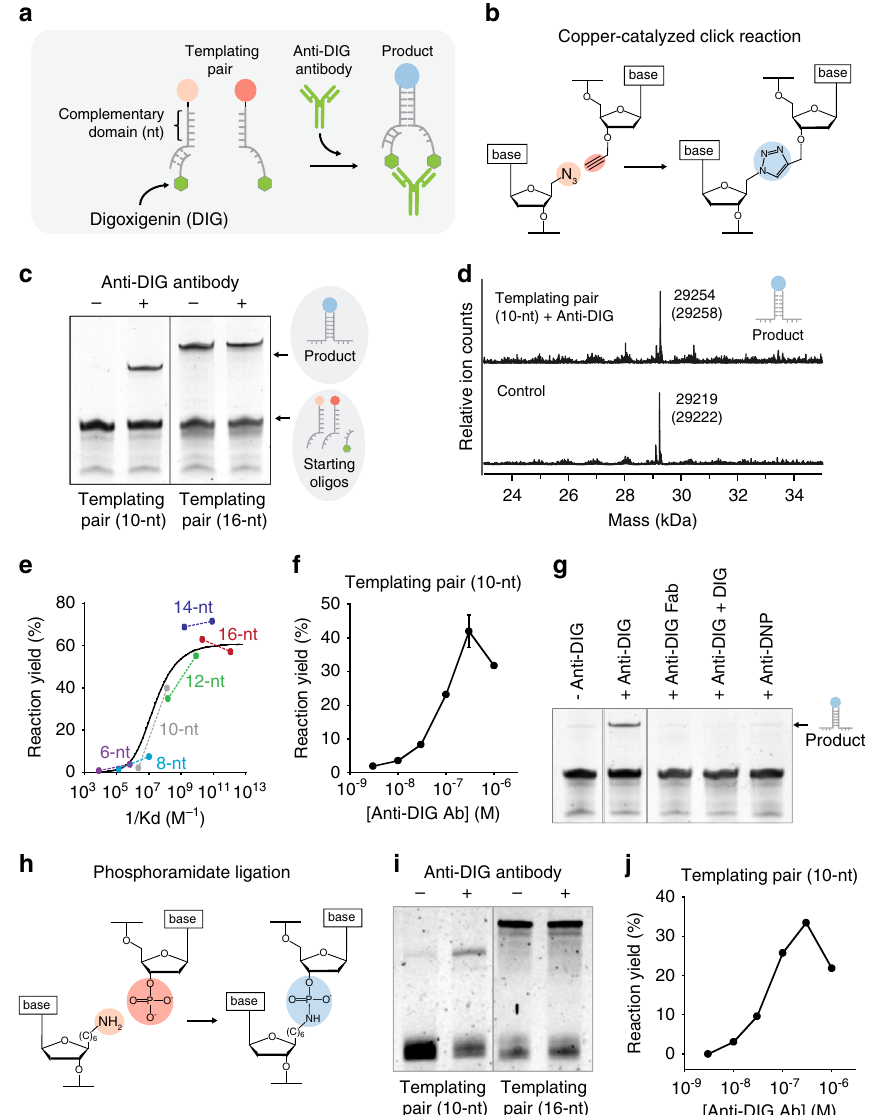
Fig. 3 Antibodies as co-templating agents for chemical reactions. a Scheme of the reaction triggered by anti-DIG antibody. The templating pairs were modi fi ed with the reactive groups and with an antigen (green hexagon, here digoxigenin, DIG). b Azide and alkyne groups leading to CuAAC reaction were used as reactive groups. c Denaturing PAGE of CuAAC reactions in the absence and presence of anti-DIG antibody for complementary domains of 10 and 16 nt. d ESI( − ) mass spectra of the reaction in the presence and absence (control) of the anti-DIG antibody for complementary domains of 10 and 16 nt, respectively, allowing identi fi cation of the product. Observed and expected (in brackets) m/z values are indicated. e Plot of reaction yield vs. the inverse of dissociation constant. Each pair of connected dots is relative to the indicated length of complementary domains. For each pair, the dot on the left corresponds to the experimental yield in the absence of the anti-DIG antibody vs. 1/ K D_no_template , whereas that on the right corresponds to the experimental yield in the presence of anti-DIG antibody vs. 1/ K D_Anti_DIG_Ab . The solid curve is the theoretical yield obtained by fi tting the experimental points to the kinetic model of the system. f Reaction yield determined by densitometric analysis of PAGE bands at different concentrations of anti-DIG antibody (with 10-nt templating pair). g Denaturing PAGE of CuAAC reactions carried out in the absence of co-templating agent ( fi rst lane) or in the presence of anti-DIG antibody (lane 2), monovalent anti-DIG Fab fragment (lane 3), anti-DIG antibody and saturating concentration of free DIG (1 μ M) in solution (lane 4) and a nonspeci fi c antibody (anti-DNP) (lane 5). h Scheme of phosphoramidate ligation triggered by the anti-DIG antibody. In this case, amine and phosphate groups were used as reactive groups. i Denaturing PAGE of phosphoramidate reactions in the absence and presence of anti-DIG antibody for complementary domains of 10 and 16 nt. j Reaction yield determined by densitometric analysis of PAGE bands at different concentrations of anti-DIG antibody (with 10-nt templating pair). Templated CuAAC reactions in this fi gure were all performed at 37 °C for 2 h at a 100 nM concentration of templating strands and 300 nM of the corresponding antibody in presence of Cu(l) catalyst in 25 mM HEPES buffer pH 7.2, 0.1 M NaCl. Templated phosphoramidate reactions were performed at 37 °C for 2 h at 100 nM concentration of templating strands and 300 nM of anti-DIG antibody in presence of 25 mM EDC.HCl and 100 mM 1-(2-hydroxyethyl) imidazole in 25 mM HEPES buffer pH 7.2, 0.1 M NaCl. The experimental values represent averages of three separate measurements and the error bars re fl ect the standard deviations. Source data are provided as a Source Data fi